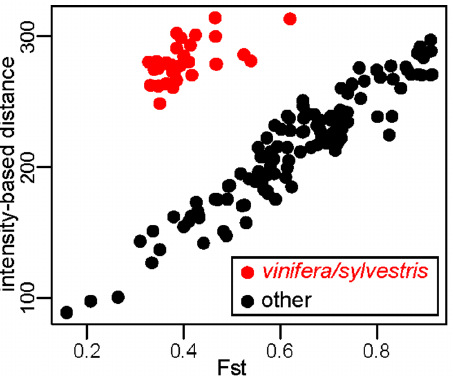
Figure 6. Comparison of genetic distance metrics based on genotype calls and hybridization intensities. Each dot represents a pairwise comparison between two species. Pairwise comparisons involving V. vinifera or V. sylvestris are highlighted in red. Genetic distances for V. vinifera and V. sylvestris based on intensity values are systematically elevated compared to other pairwise